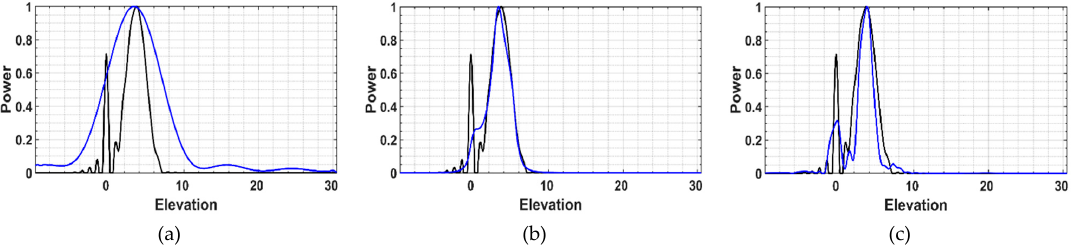
Figure 2. Extracted span profiles of the simulated scenario with full-rank reconstruction of T , ( a ) Beamforming, ( b ) Capon, ( c ) the proposed method. Blue and black indicate the reconstructed and simulated signals.